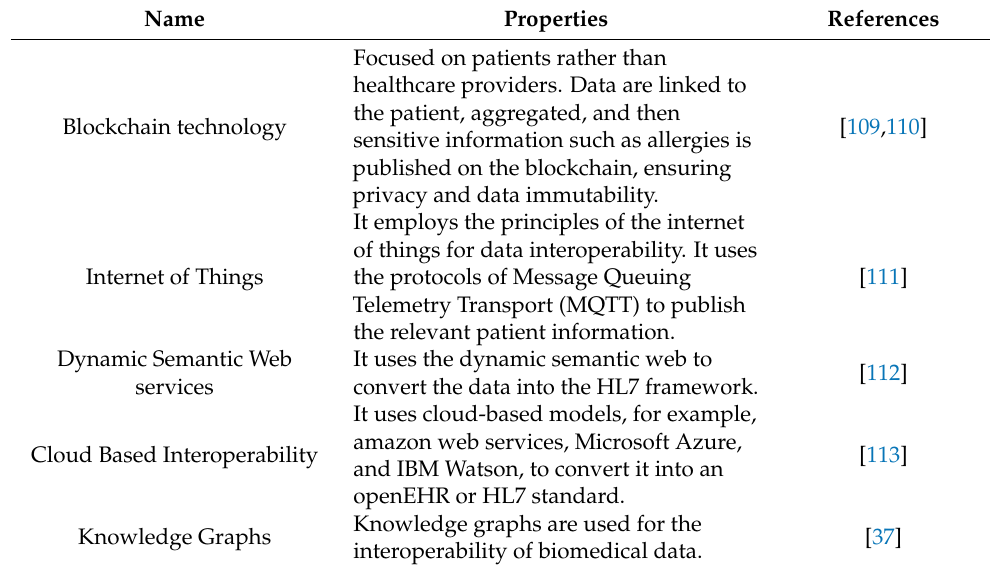
Table 5. Comparison of interoperability